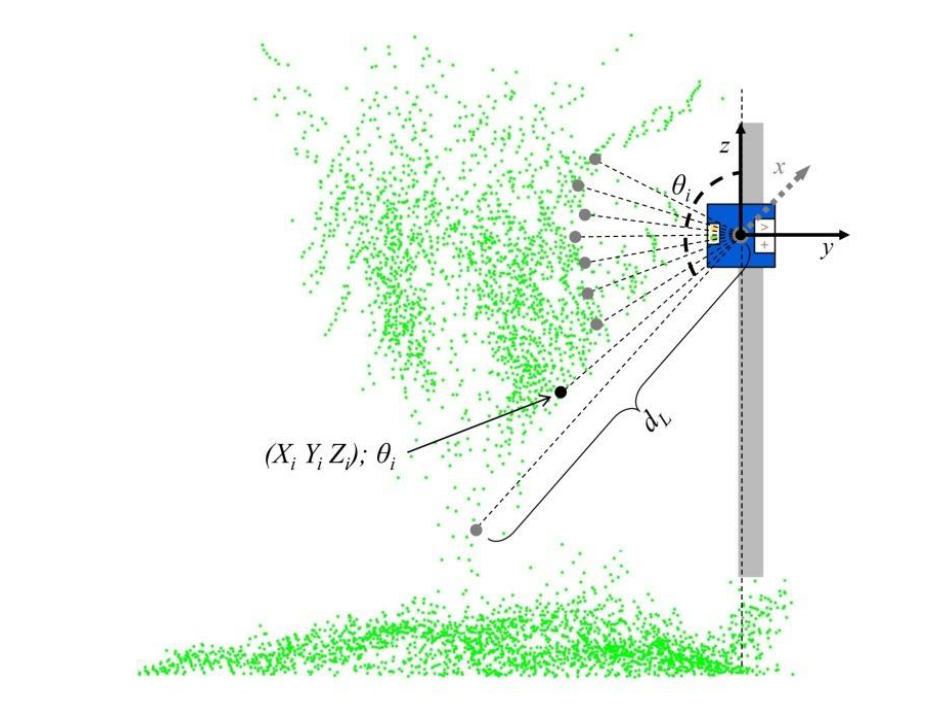
Figure 7. Spot cloud of measurements obtained using the LiDAR sensor. For each point, the georeferencing method allows the UTM coordinates to be defined. Green points represent the total measurement data for the canopy. Grey points represent values obtained in one